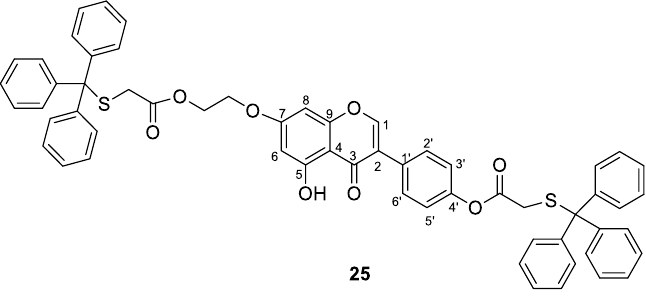
Figure 3. Structure of the impurity 25 .